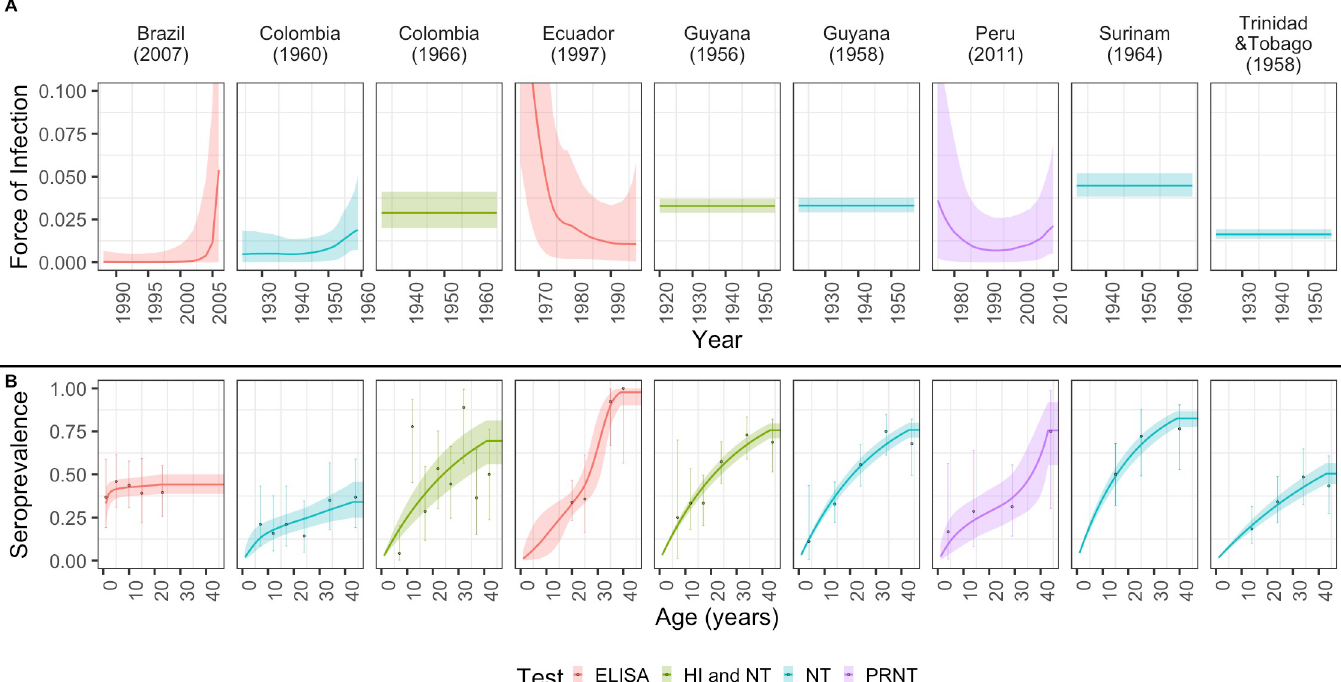
Fig 5. MAYV exposure patterns in Latin America. (A) FOI estimates obtained from catalytic models fitted to MAYV age-stratified seroprevalence data. B) Data (points) and estimated (line) age-stratified seroprevalence against MAYV. Points and dark lines represent mean estimates; bars and shaded areas represent the 95% CrI. Colours indicate the type of test used to confirm cases.